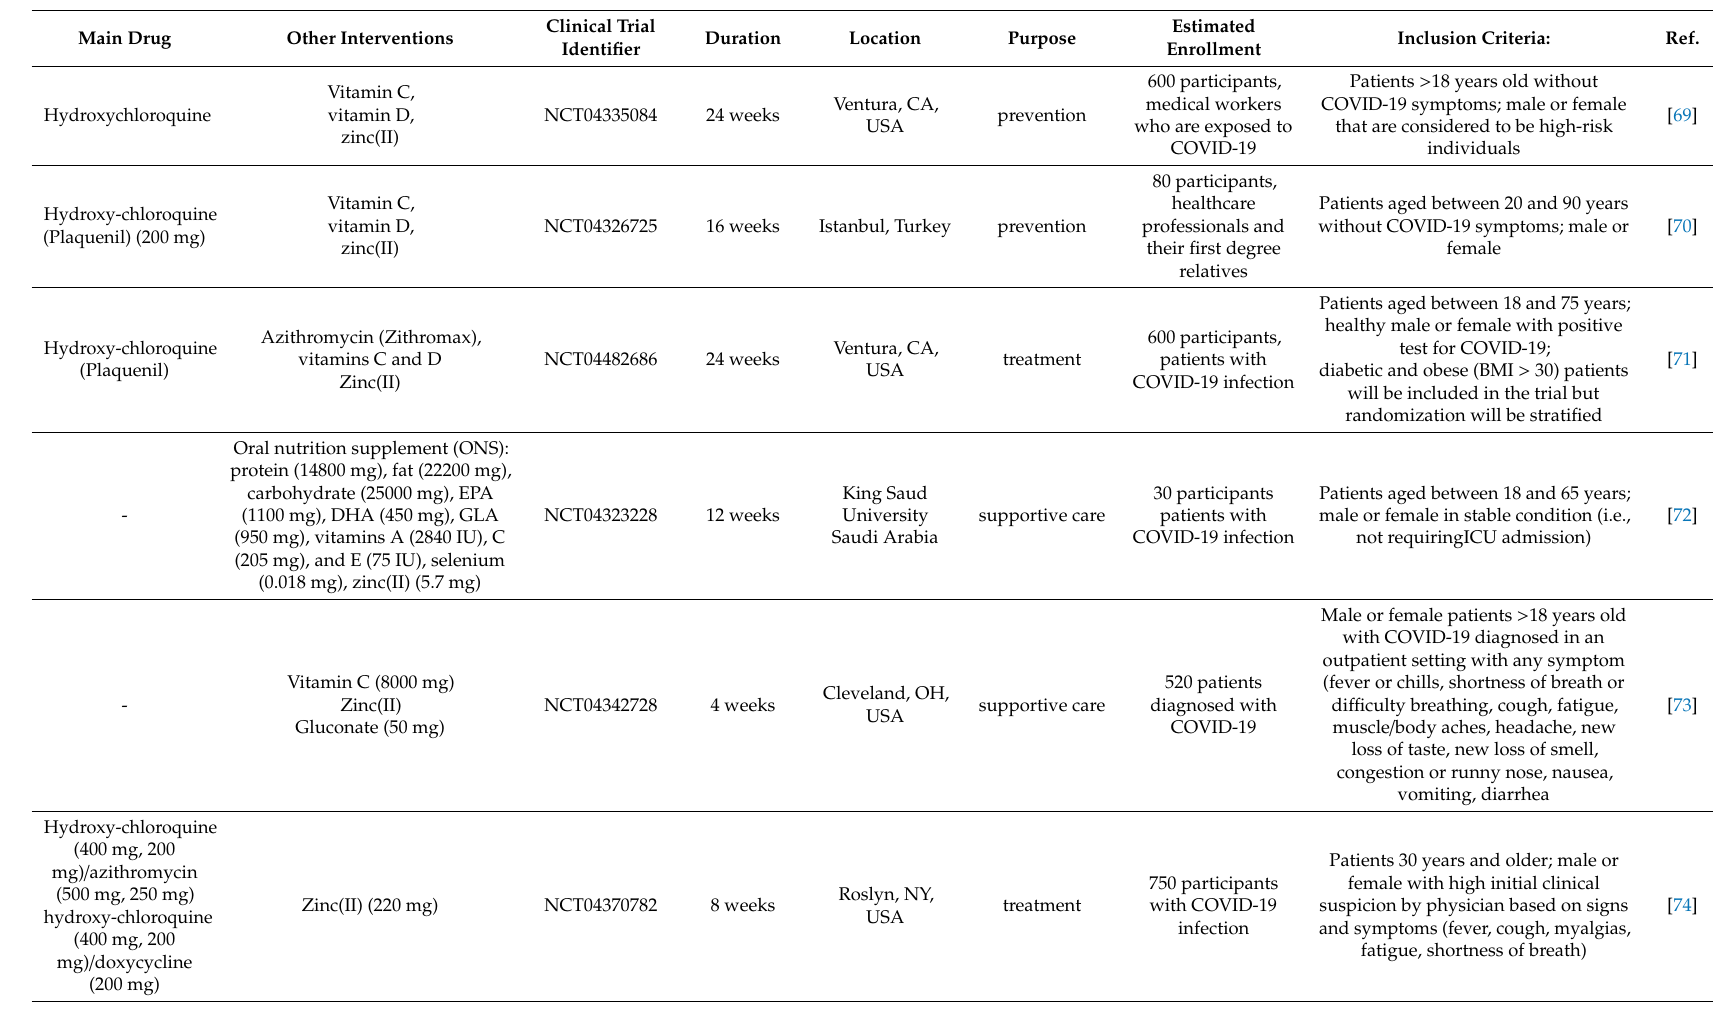
Table 1. Characteristics of clinical trials concerning zinc(II) as a treatment of